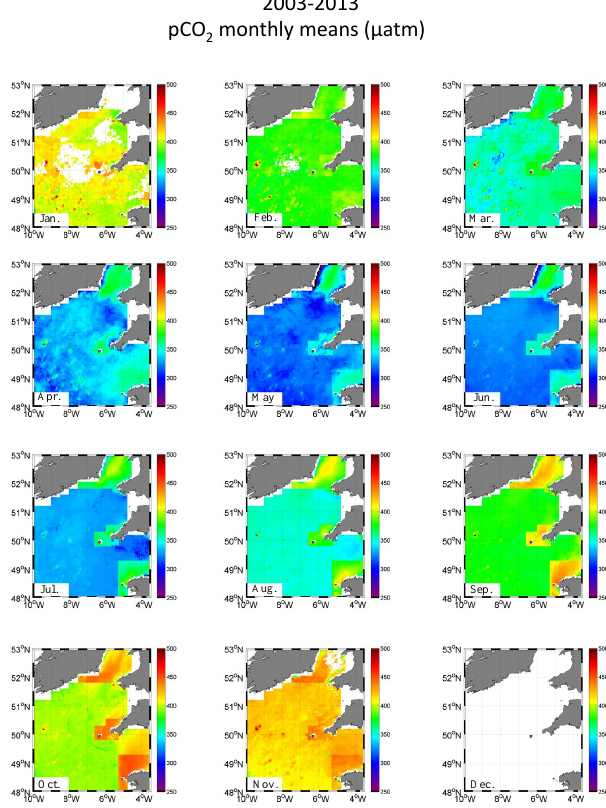
Figure 10. Monthly p CO 2,MLR (µatm) computed from the algo- rithms developed in seasonally stratified and in permanently well- mixed systems, averaged from 2003 to 2013 from January (top left corner) to December (bottom right